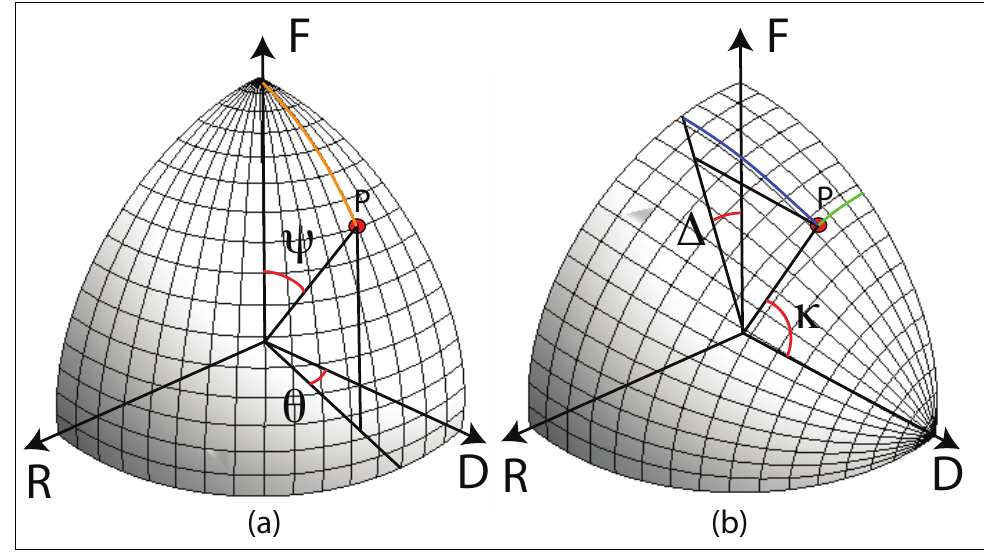
Figure 1. The representation of the transformation given by an homogeneous retarding diattenuater on the generalized retardation sphere, a portion of an analogy to the Poincaré sphere. ( a ) Polar coordinates ψ , θ aligned on the F -axis; ( b ) polar coordinates κ , ∆ aligned on the D - axis The Cartesian coordinates D = cos κ and R = sin ∆ sin κ are the diattenuation and the retardation, 0 ≤ ( D , R ) ≤ 1. The coordinate F = cos ∆ sin κ , − 1 ≤ F ≤ 1, is a measure of the strength of the polarization transformation, with the point F = 1 corresponding to no change, and the circle F = 0, D 2 + R 2 = 1 to a quarter-wave retarding diattenuater. The point F = − 1, D = R = 0 (not shown) corresponds to a half-wave